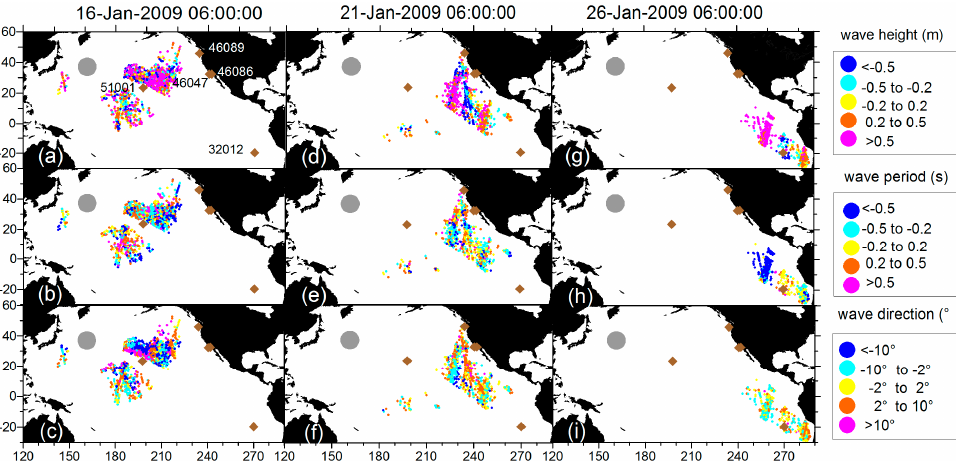
Figure 12. Differences in swell height, wave period, and wave direction between the EnKF field and observations at 16-, 21-, and 26-Jan-2009 06:00:00.